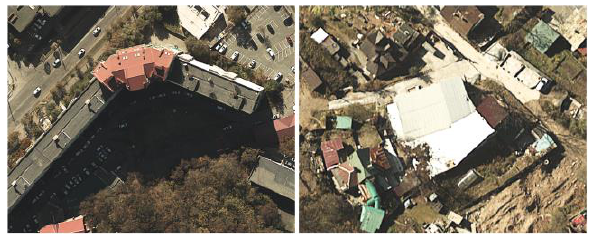
Figure 7. Loss of information in shadows (left) and illumination (right) on aerial images